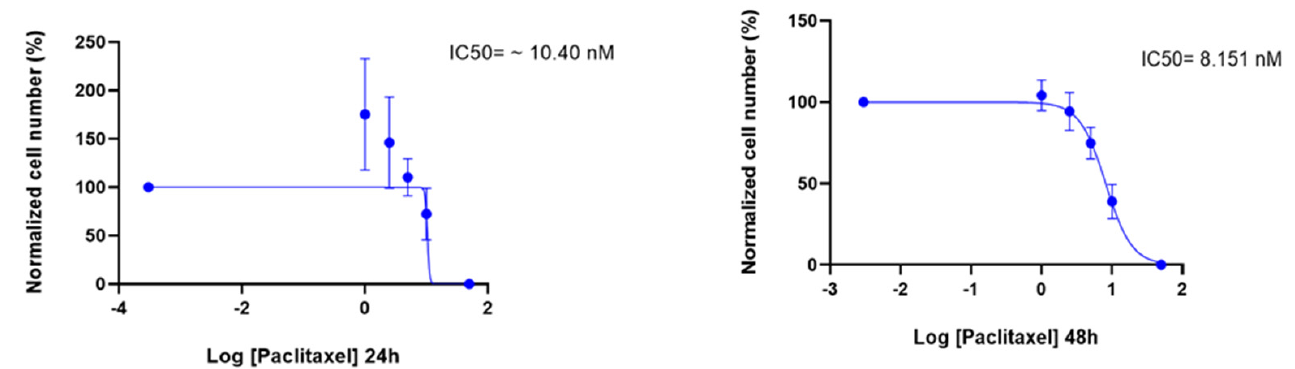
Figure 6. Representation of paclitaxel dose-response curve at 24 h (left graph) and 48 h (right graph). The curve represents a normalization between 0 and 100%, where 100% was defined as the concentration of the drug that least affected the cell viability, and 0% was considered the concentration that most affected the cell viability. Results are expressed as mean ± standard error of the mean (SEM). The IC50 value was calculated using the normalized data (between 0% and 100%). Additional analysis demonstrated that the cell viability of MCF-7 cells between 24 h and 48 h was significantly lower for the 5 nM ( p < 0.05), 10 nM, and 50 nM concentrations ( p < 0.0001). These data confirm that prolonged drug time exposures are more effective (Figure 7).